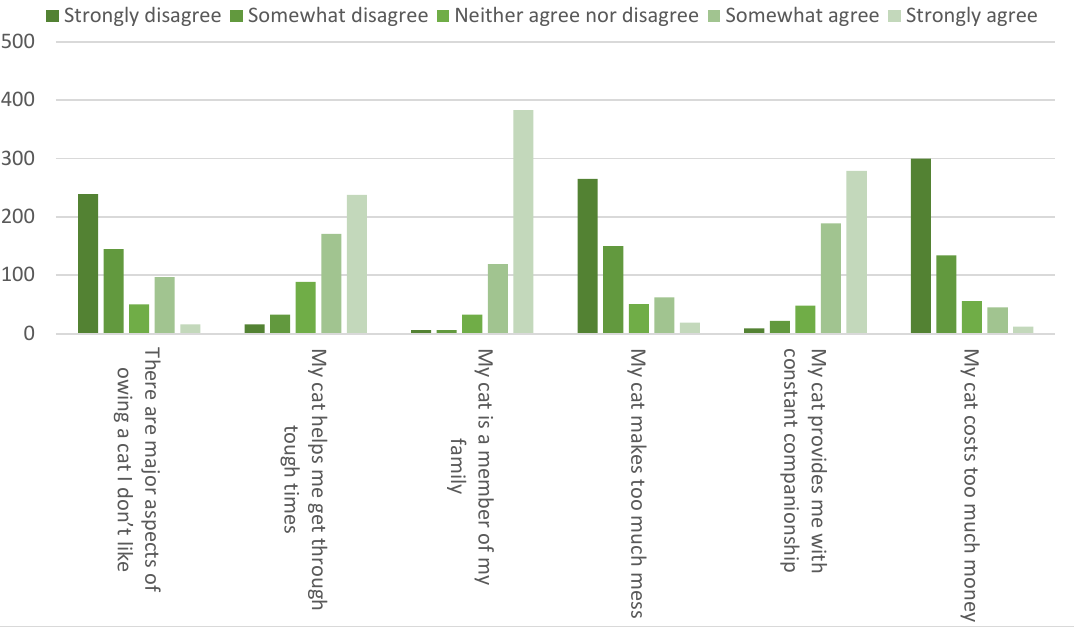
Figure 2. Cat owner responses to questions related to their bond with their cat. ( a ) Response options ranged from 1-“at least once per day” to 5–“never”. ( b ) Response options ranged from. 1–“strongly disagree” to 5–“strongly agree”.